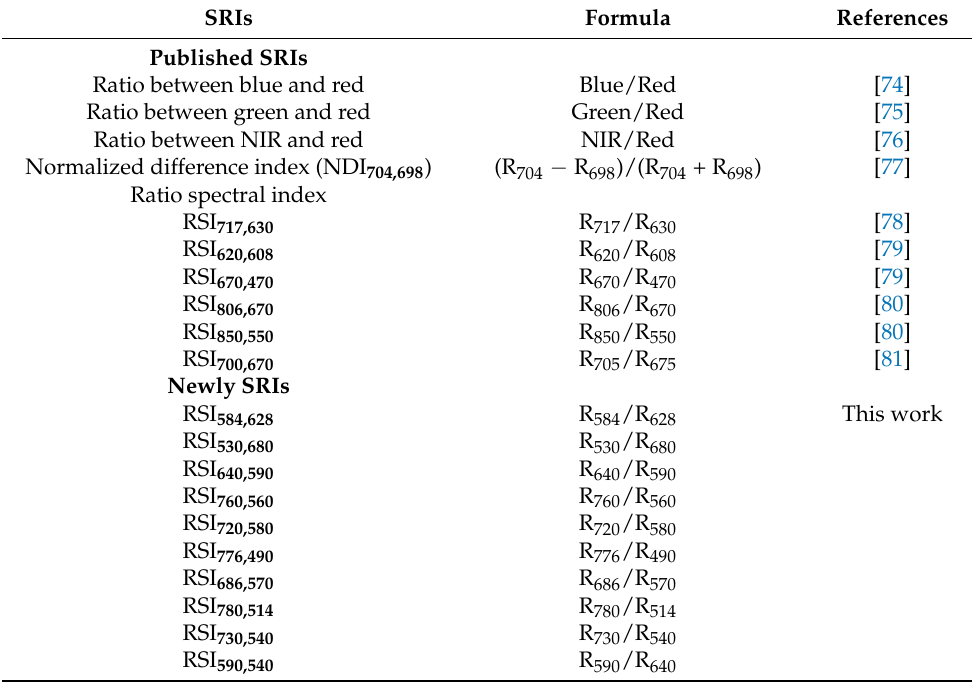
Table 3. Description of different SRIs examined in this